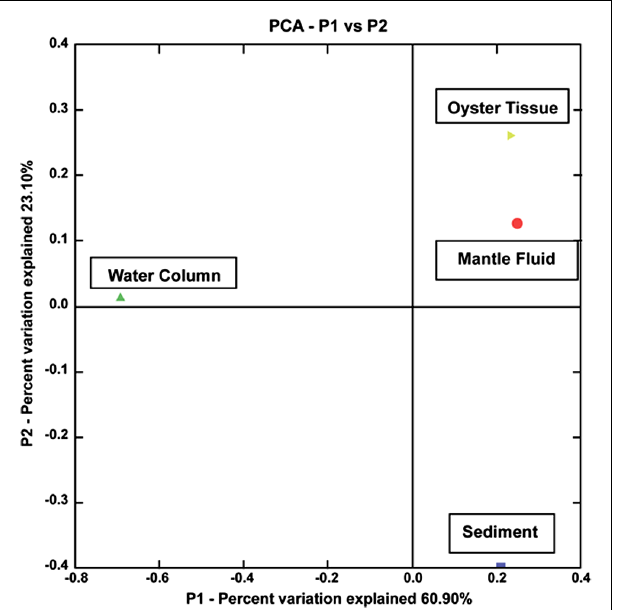
FIGURE 4 | Shown is a principal component analysis (PCA) obtained from UniFrac analysis of the 16S rRNA sequences of 72 isolated strains from the oyster tissue (yellow triangle), mantle fluid (red circle), water column (green triangle), and sediment (blue square). The percentages on each of the axes show the percent variation explained by each